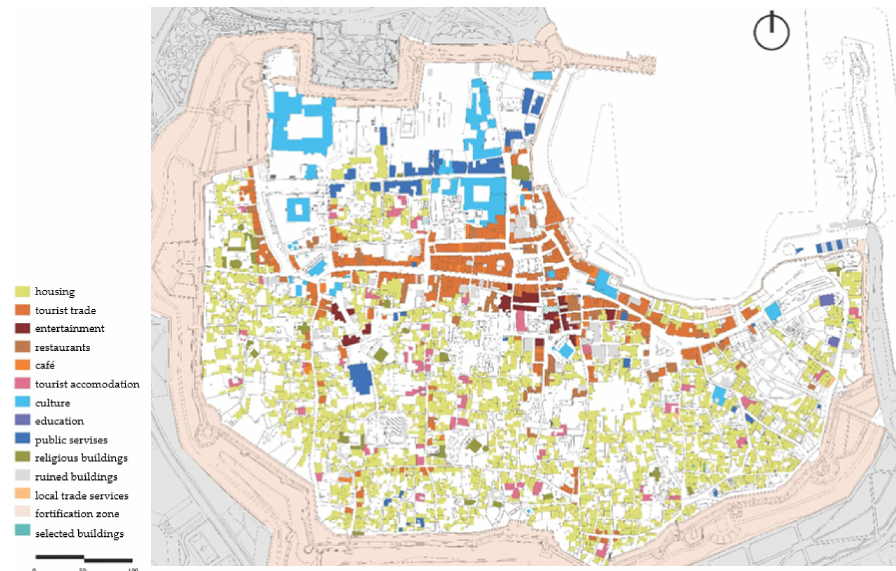
Figure 15. Existing land uses of the Medieval City.